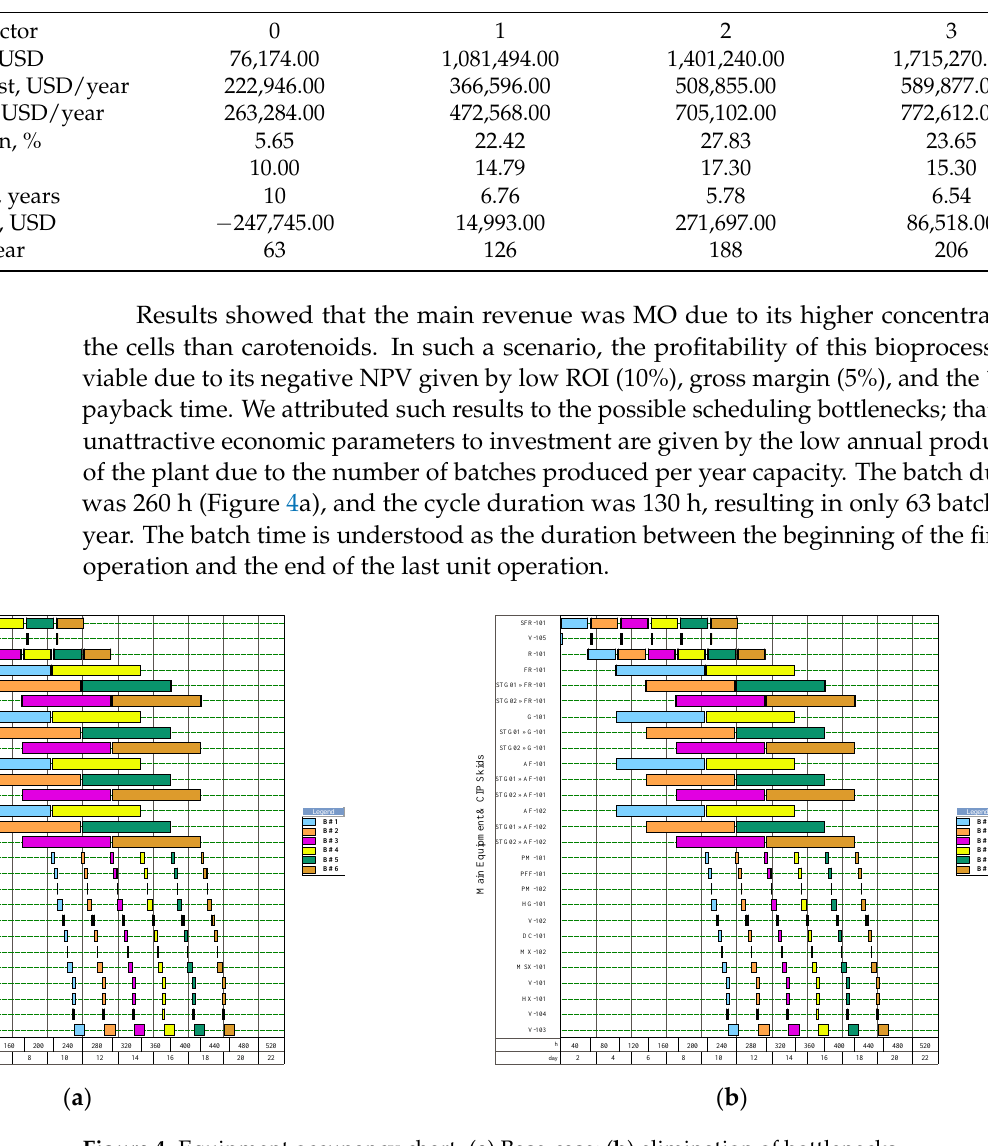
Figure 4. Equipment occupancy chart. ( a ) Base-case; ( b ) elimination of bottlenecks.